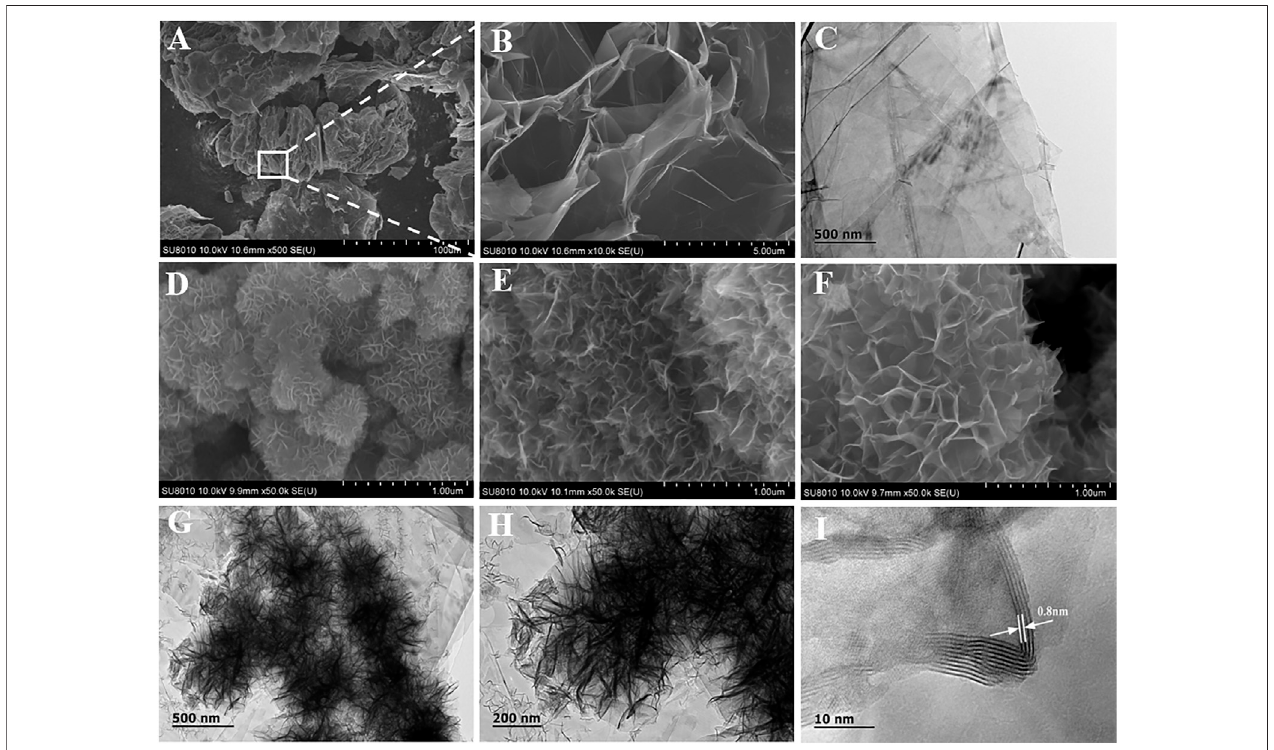
FIGURE 2 | The microstructure of pure TE-G (A – C) and the composites with the KMnO 4 /TE-G ratio of 5 (D) , 20 (E) , and 10 (F – I) by SEM and TEM.